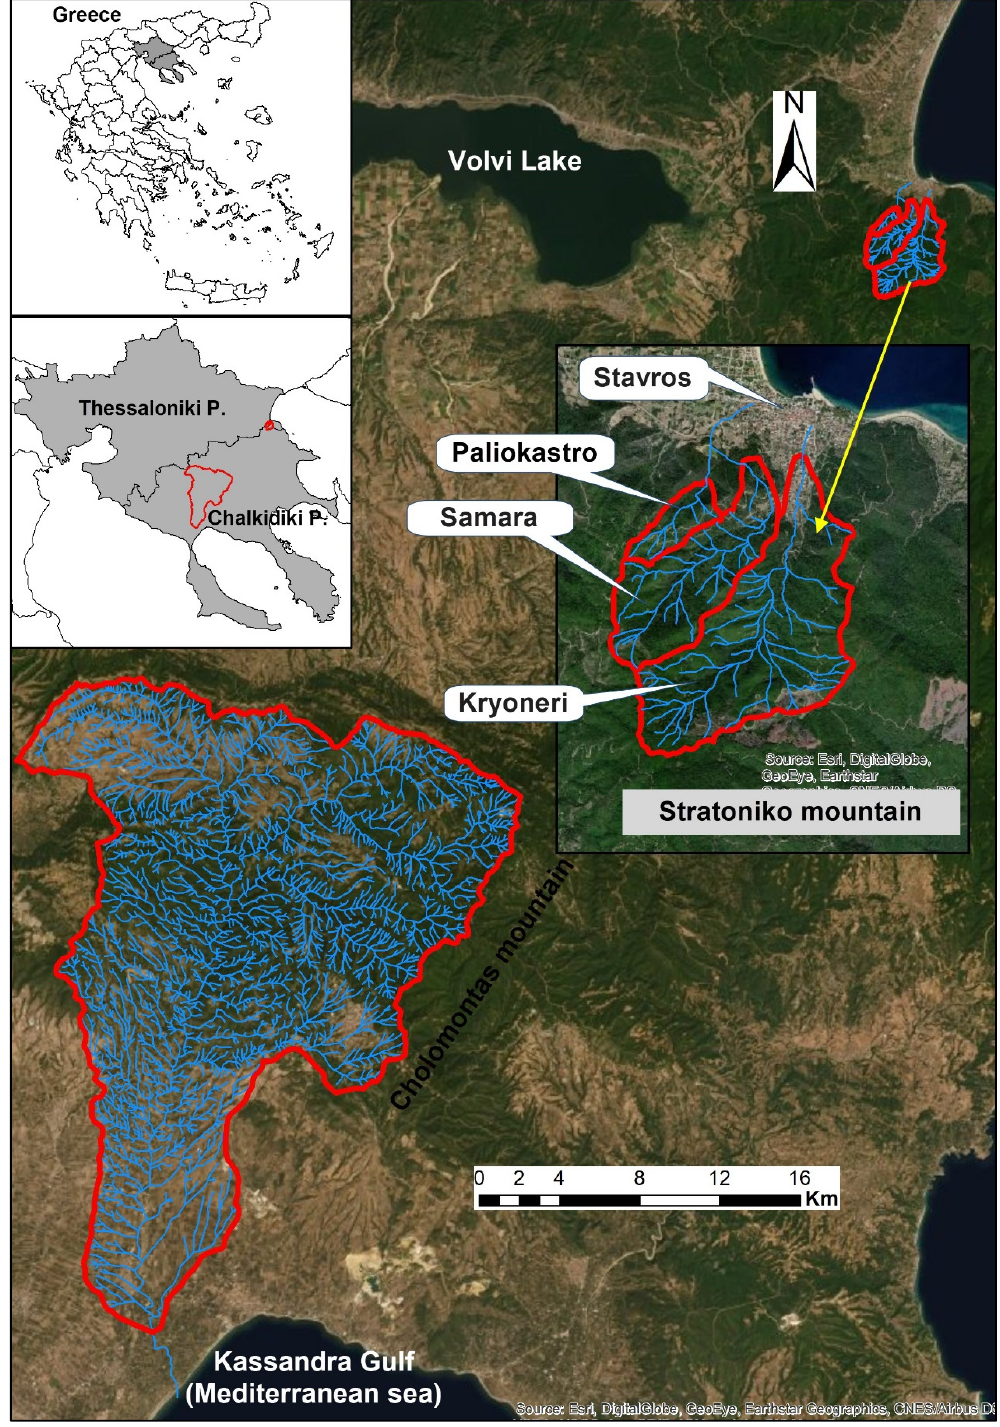
Figure 1. The four watersheds included in the study area.